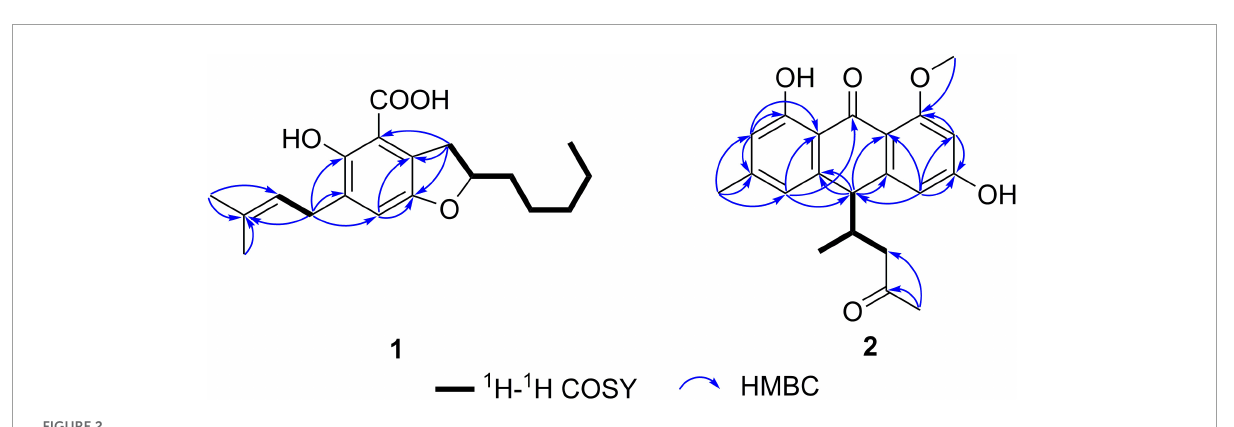
FIGURE1 The chemical structures of compounds 1 – 15 .